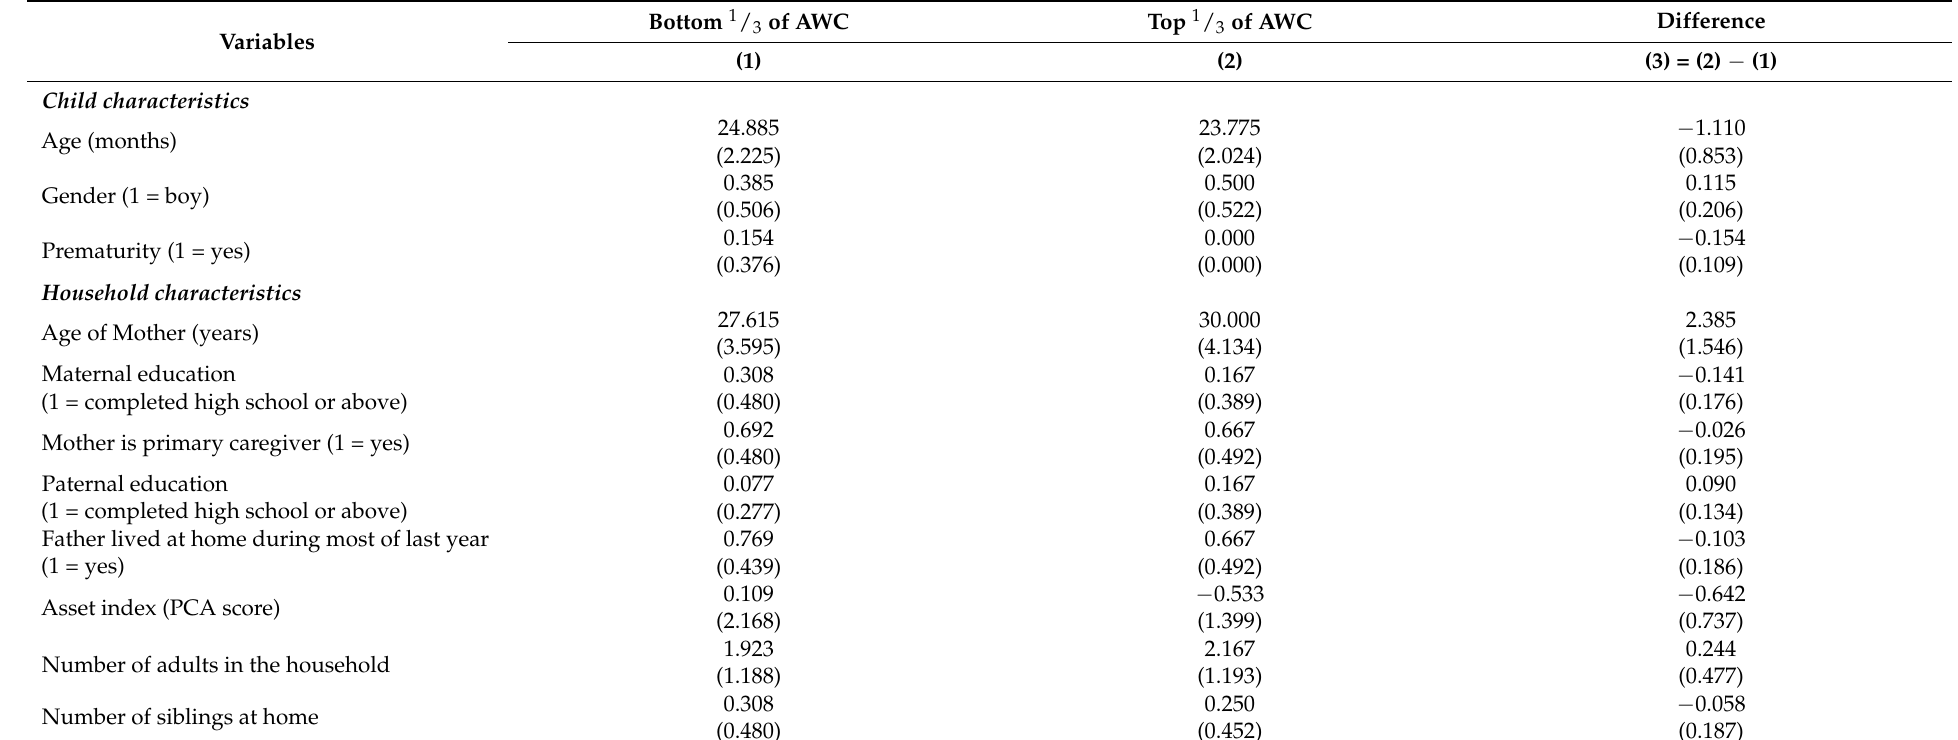
Table 2. Differences in characteristics between top and bottom terciles of Adult Word Count (AWC, N =